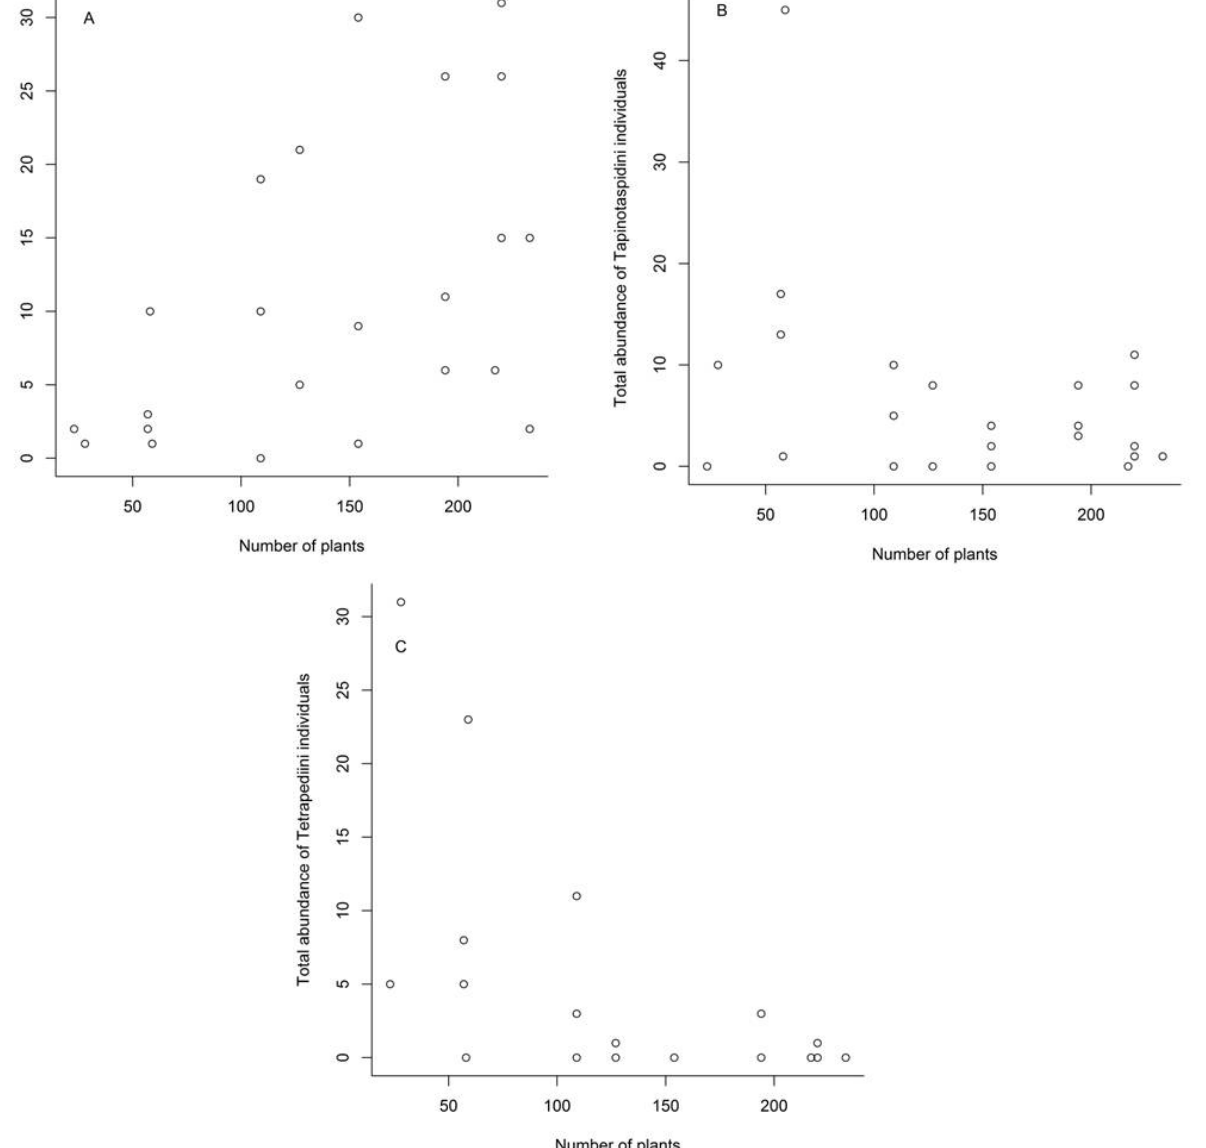
Fig 1. Total number of individuals of Centridini (A), Tapinotaspidini (B) and Tetrapediini (C) in relation to the number of Byrsonima plants in a cerrado area in Chapada Diamantina, northeastern Brazil. Each dot represents one sampled transect per month (there are superimposed